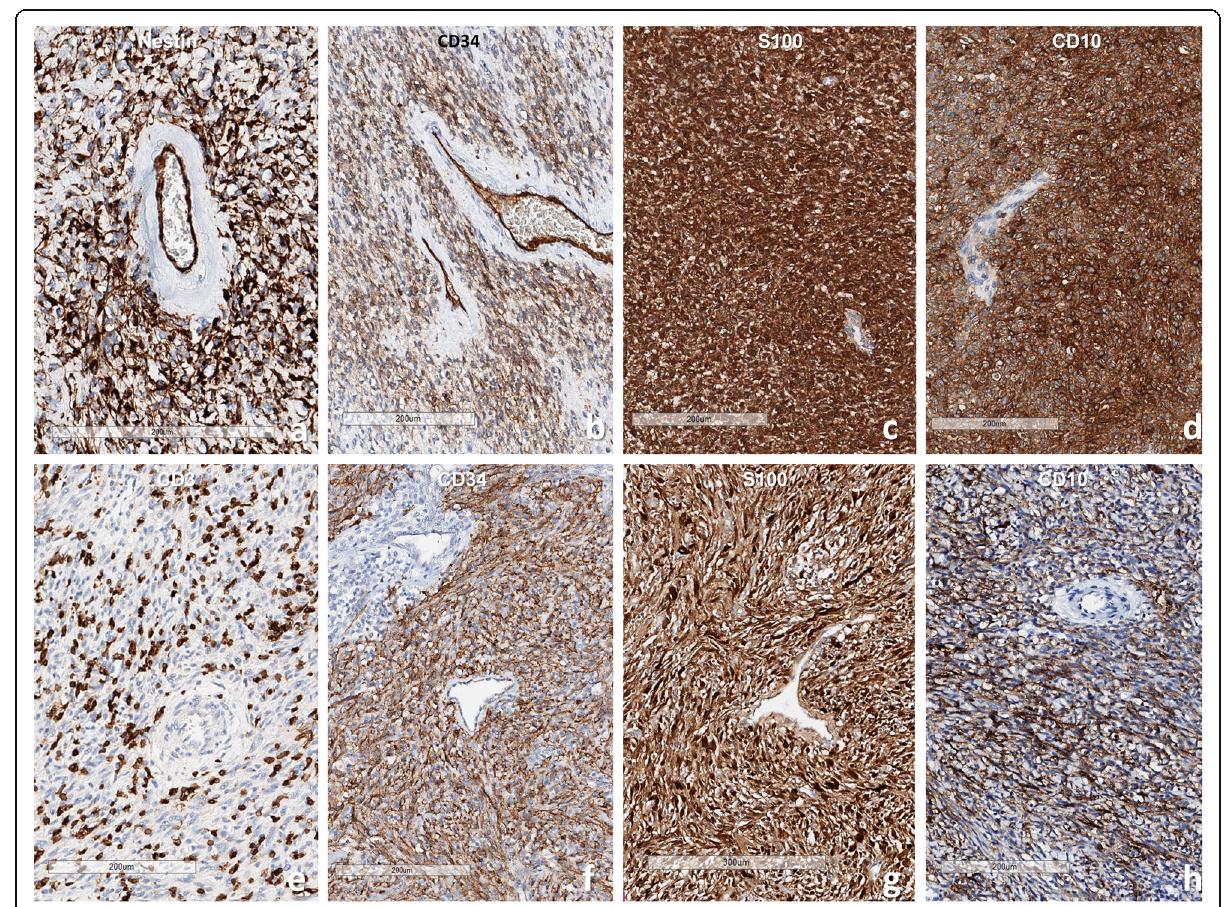
Fig. 4 a , b Sarcoma with TPR-NTRK1 fusion shows co-positive for nestin and CD34. c , d ETV6-NTRK3 fusion-positive infantile fibrosarcoma is co- positive for S100 protein and CD10. e - h The LMNA-NTRK1 fusion sarcoma has lots of CD3-positive T-cell infiltration and robustly coexpressed CD34, S100, and CD10. ( a : nestin, b, f : CD34, c, g : S100 protein, e : CD34D, h : CD10, Bar: 200 μ